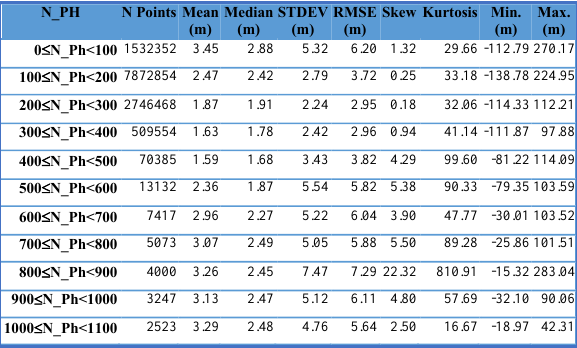
Table 6. Statistics for elevation differences SRTM90